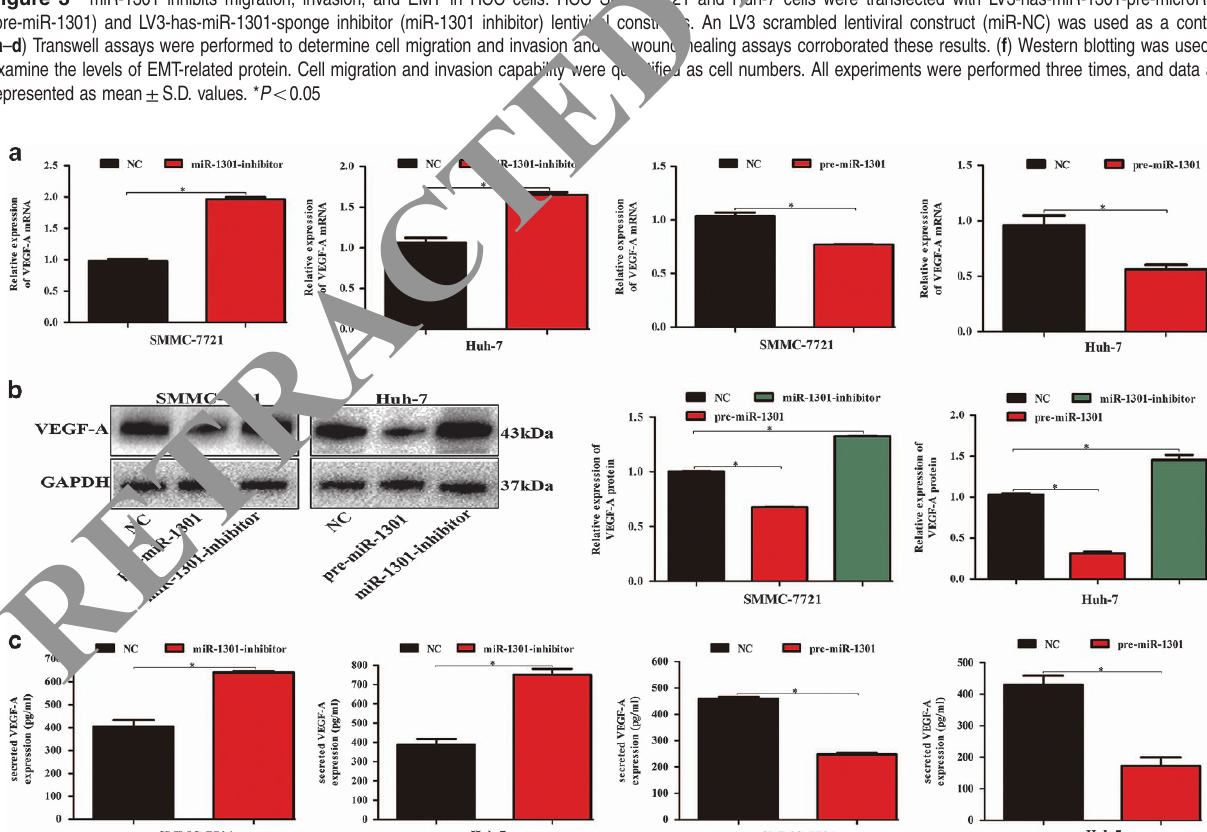
Figure 4 miR-1301 inhibits VEGF expression. ( a ) qPCR was used to analyze the levels of VEGF-A expression in SMMC-7721 and Huh-7 cells transfected with miR-NC, the miR-1301 inhibitor, or pre-miR-1301. ( b ) VEGF-A protein levels were analyzed by western blotting. ( c ) ELISA was used to determine the VEGF-A concentration in the culture medium of SMMC-7721 and Huh-7 cells transfected with miR-NC, the miR-1301 inhibitor, or pre-miR-1301. * P o